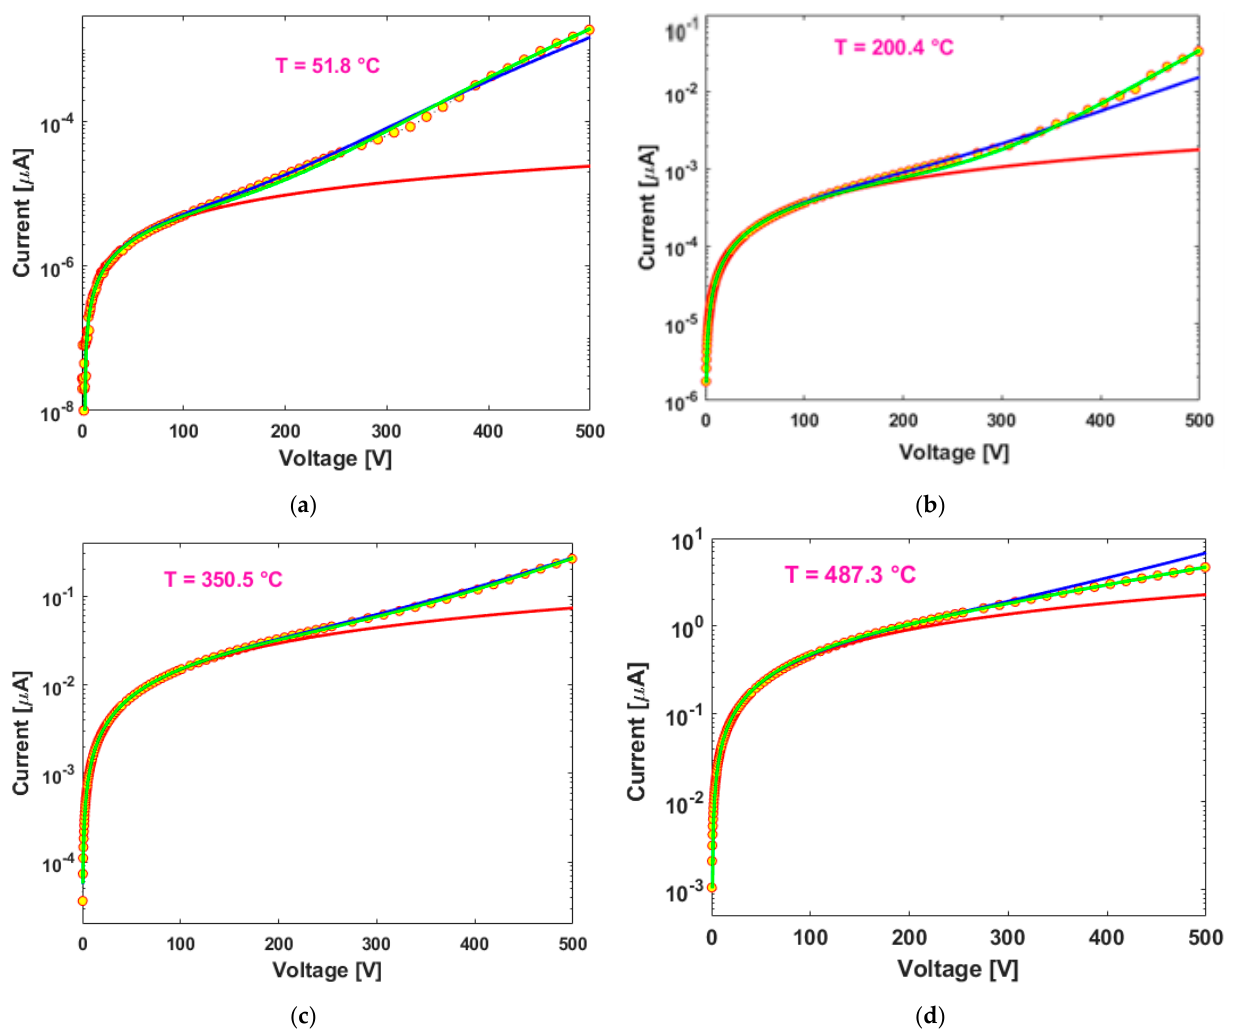
Figure A1. I/V curves relative to the negative voltage ramp with corresponding Matlab fitting for the linear part (red line), the first exponential part up to 230 V (blue curve) and the total exponential behavior up to maximum voltage of 500 V (green curve). ( a ) n. 23 measurement at about 50 ◦ C; ( b ) n. 15 measurement at about 200 ◦ C; ( c ) n8 measurement at about 350 ◦ C; ( d ) n. 1 measurement at about 500 ◦